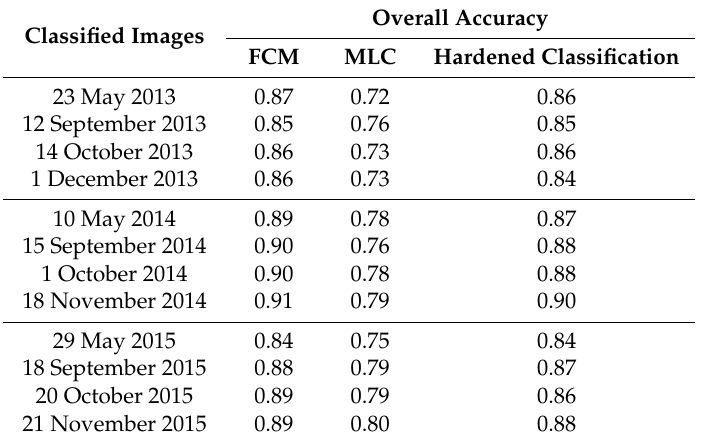
Table 4. Summary of the overall classification accuracy using FCM, MLC and hardened classification.